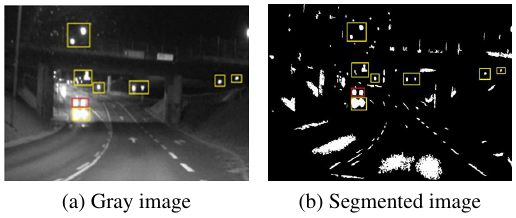
Figure 4. Features based on size and position.